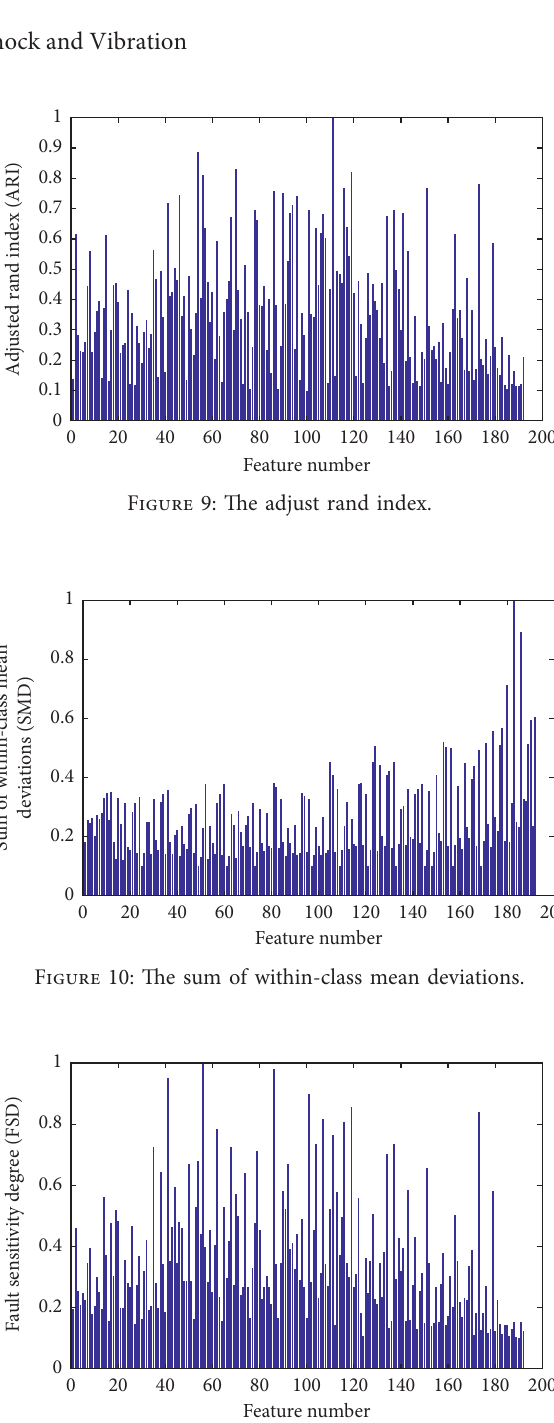
Figure 11: The fault sensitivity degree features of the training samples.